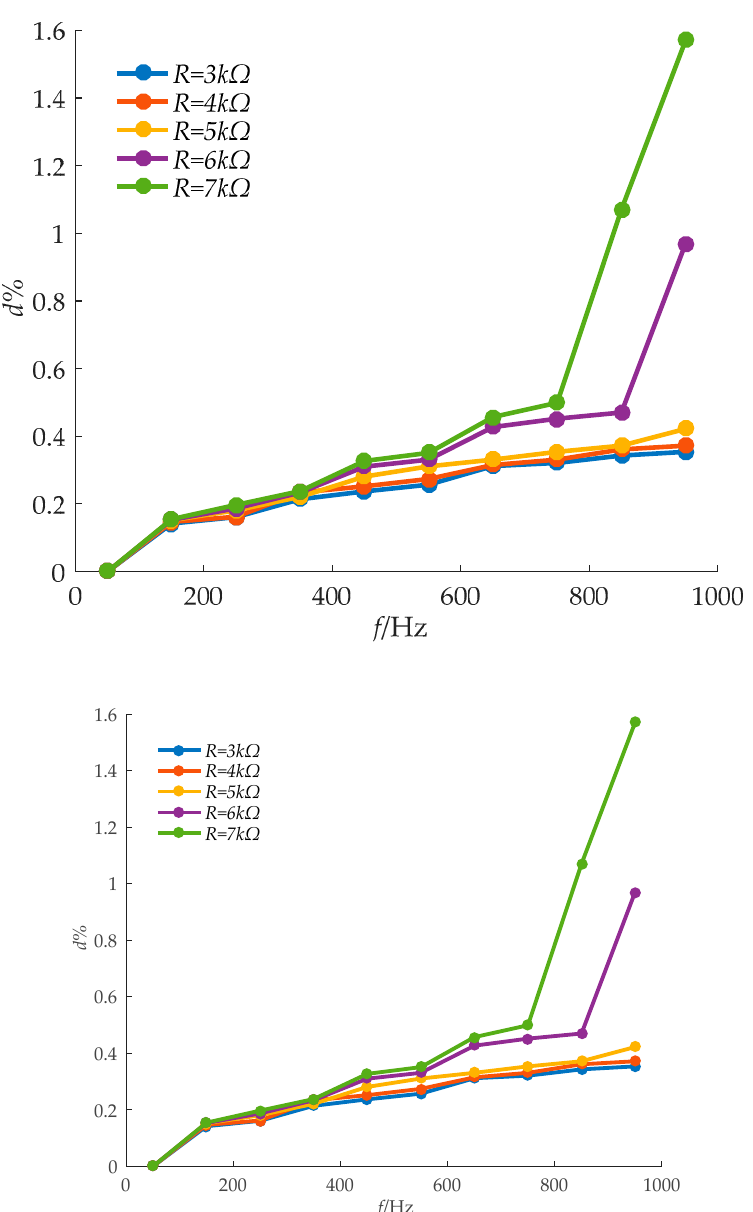
Figure 13. Relationship between harmonic and the voltage error for different divider resistance. Table 2. Relationship between harmonic and voltage